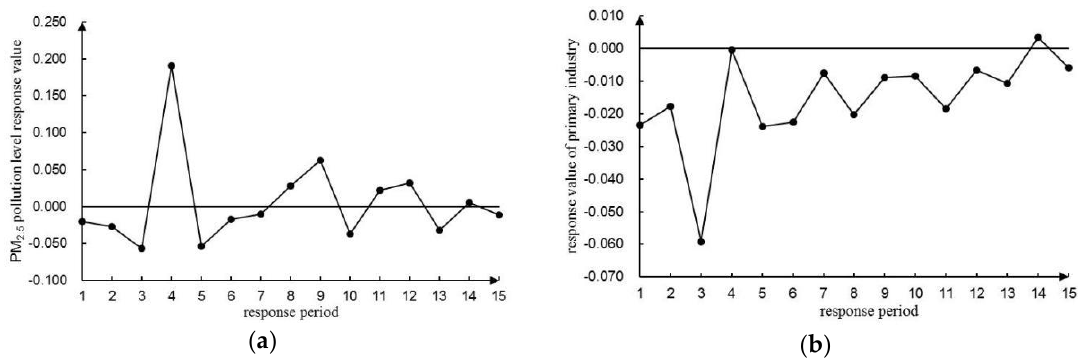
Figure 6. Impulse response function diagram of PM 2.5 pollution level and development level of the primary industry. ( a ) Impulse response function diagram of the PM 2.5 pollution level to the primary industry development level. ( b ) Impulse response function diagram of the primary industry development level to the PM 2.5 pollution level.